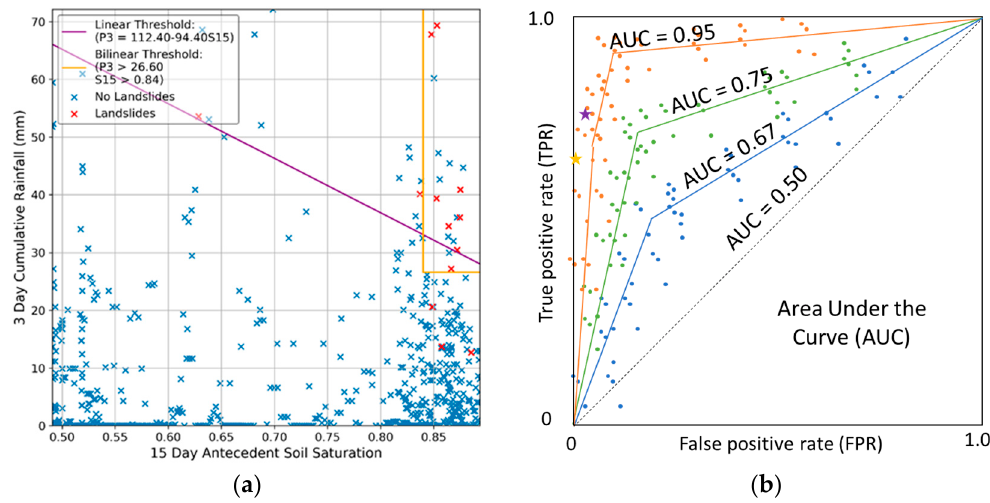
Figure 4. ( a ) Hydro-meteorological threshold space defined by 15-day antecedent saturation vs. 3-day recent-imminent rainfall (2-day recent, 1-day forecasted) totals for the Seattle-Everett railway, with comparison of simple linear (purple) and bilinear (yellow) threshold formats; ( b ) Example ROC plots showing the true positive rate (TPR) and false positive rate (FPR) with colored stars for the simple linear (yellow) and bi-linear (purple) thresholds. Plot also illustrates a hypothetical threshold development and the concept of identifying the maximum ROC curve based on clusters of points from possible thresholds tested and shows the utility of AUC as an optimization metric; dashed black line represents a random guess model (AUC = 0.5), blue (AUC = 0.67), green (AUC = 0.75) and orange lines (AUC = 0.95) represent successive improvements in threshold formulation and predictive accuracy.